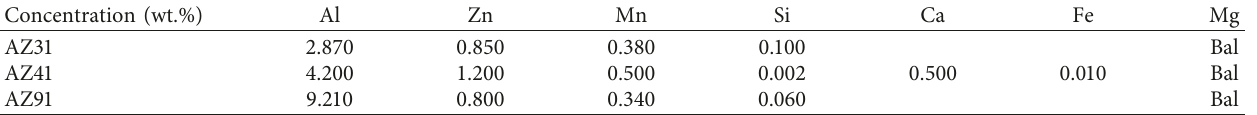
Table 2: The composition of three magnesium alloys investigated in this study. Concentration